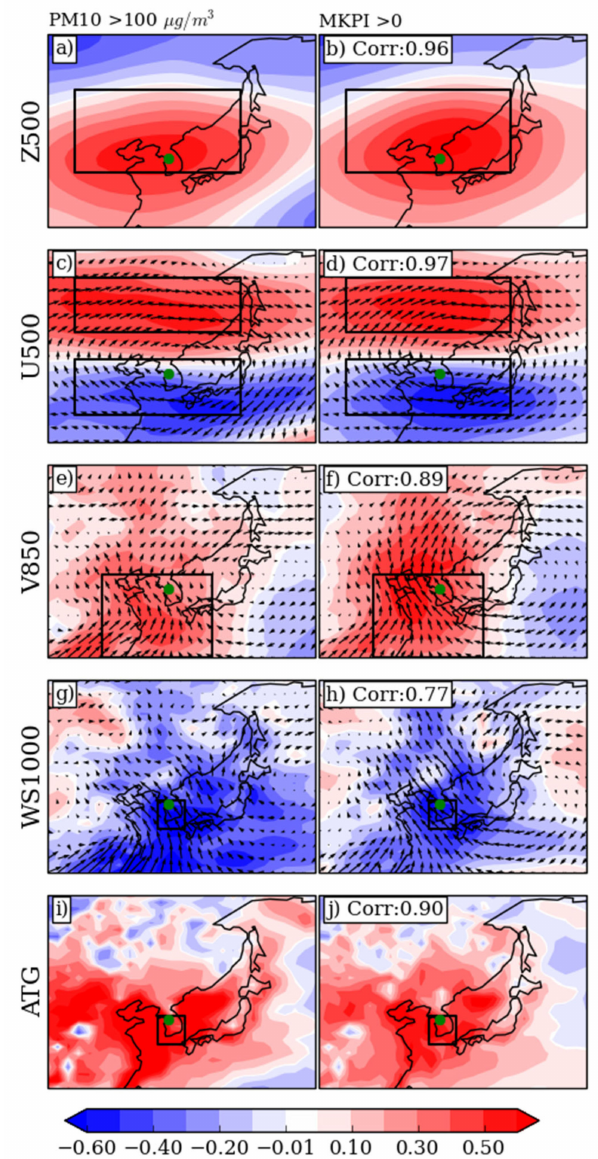
Figure 2. Composite maps for high PM 10 episodes (left column) and modified Korea particulate matter index (MKPI) > 0 (right column) of the anomalous 500 hPa geopotential height (shaded) ( a , b ), anomalous 500 hPa u-component wind (shaded) and wind (vector) ( c , d ), 850 hPa v-component wind (shaded) and wind (vector) ( e , f ), 1000 hPa wind speed (shaded) and wind (vector) ( g , h ), and ATG (vertical potential air temperature gradient, shaded) ( i , j ) during the winters of the 2001 − 2014 period. The green dots denote the location of Seoul (37.5 ◦ N, 127 ◦ E); black boxes denote the regions for the calculation of 5 indices (Z500, U500, V850, WS1000, and ATG), respectively. The anomalies are by reference to the daily standard